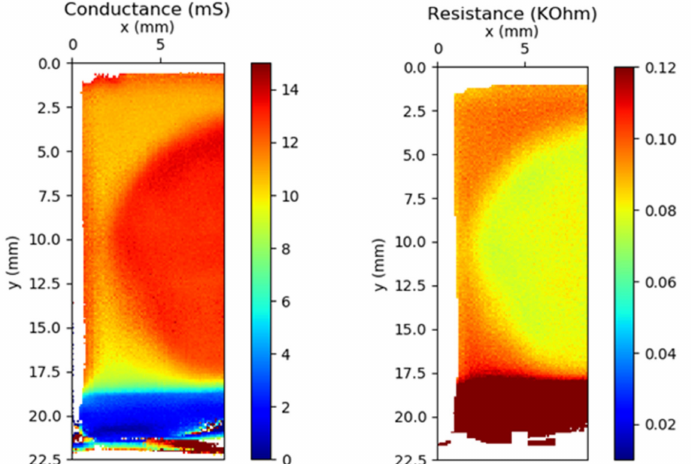
Figure 6. Conductance and resistance maps of 3 GML stacked transferred on top of the ITO / Si substrate